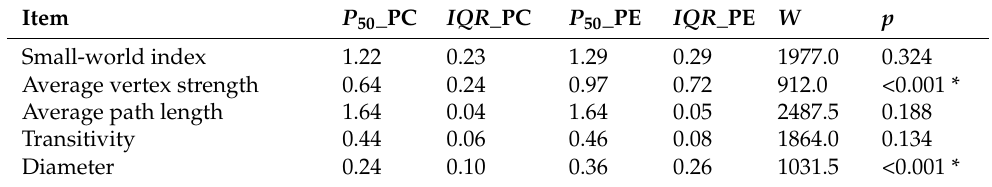
Table 4. Univariate analysis of static network characteristics.